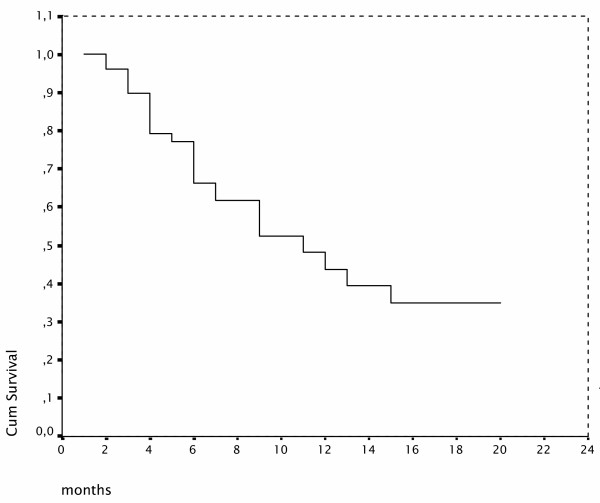
Overall survival Kaplan-Meier curve